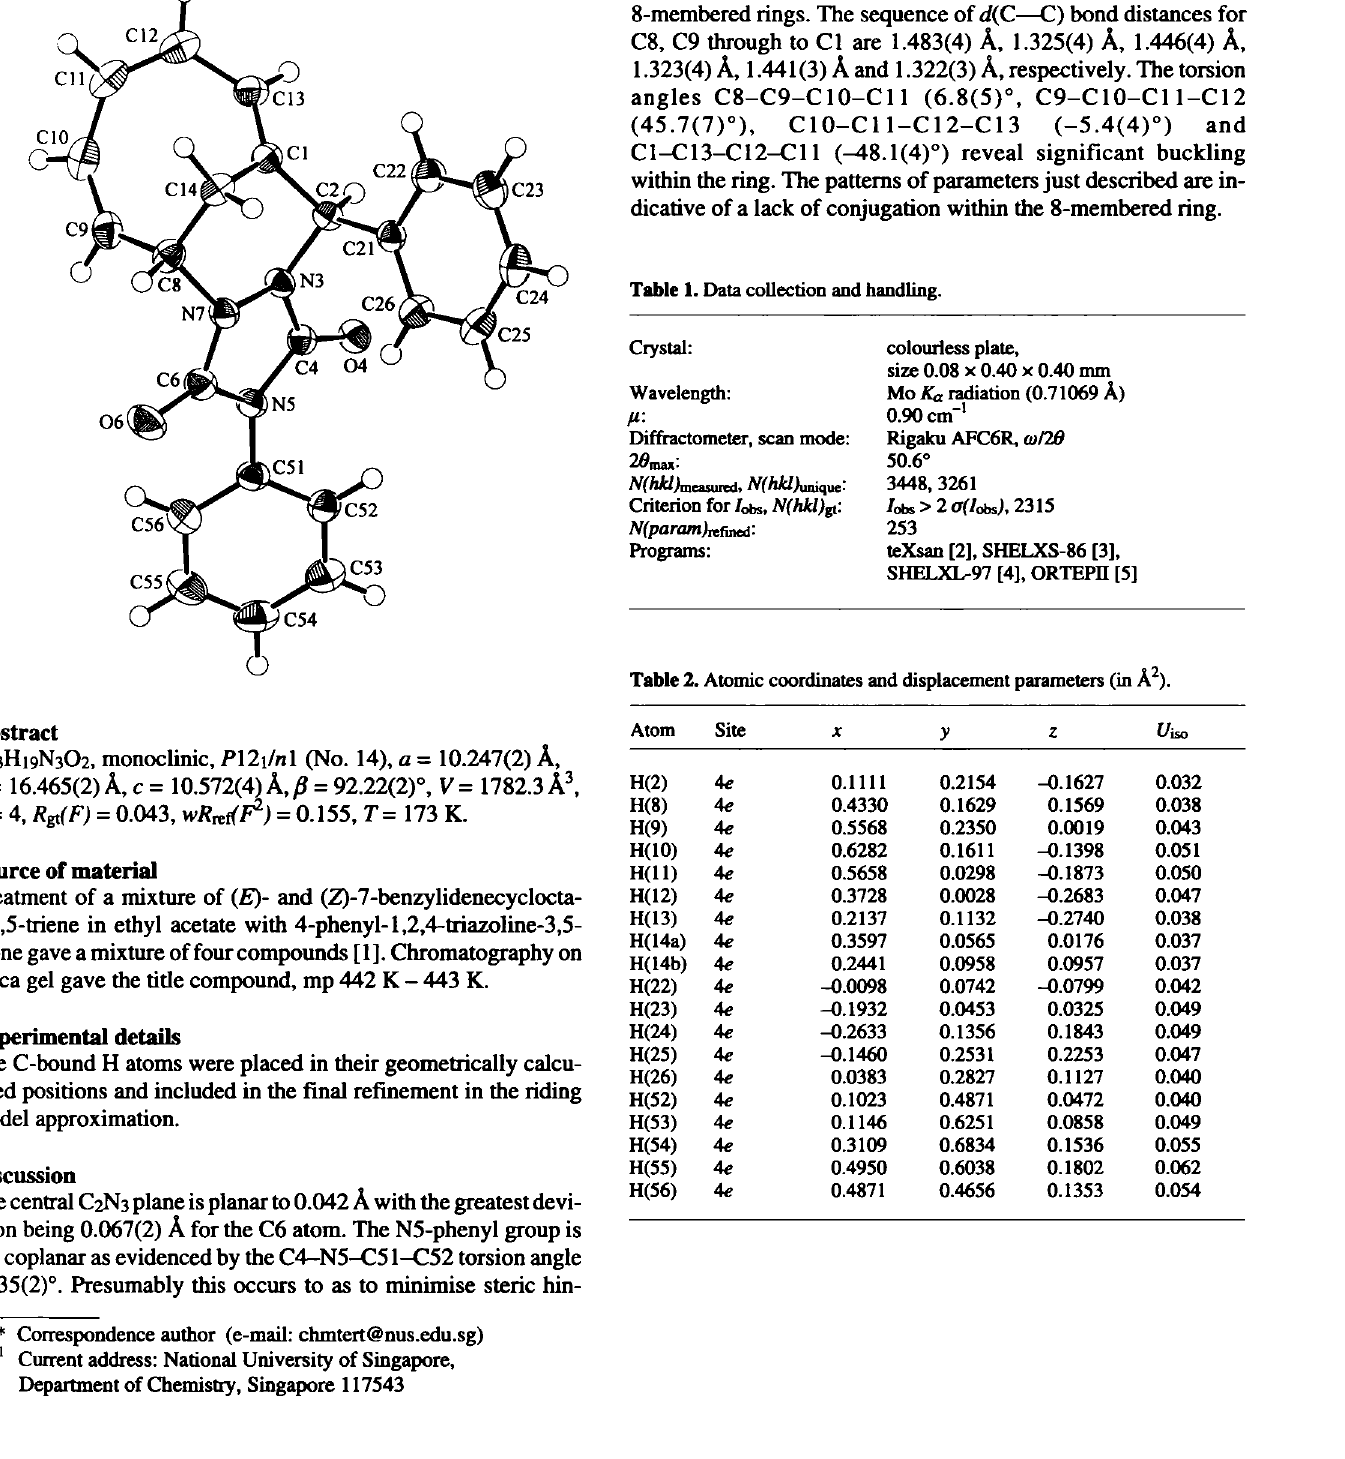
Table 1. Data collection and handling.